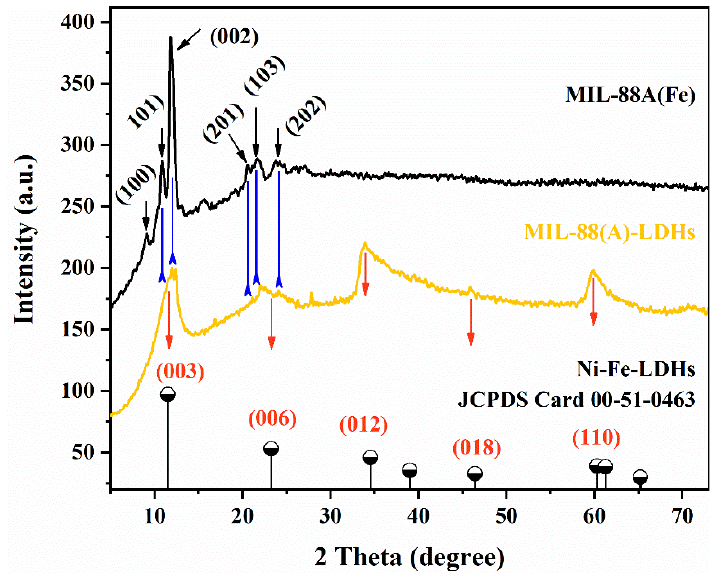
Figure 1. PXRD patterns of LDHs, MIL-88A(Fe), and MIL-88A-LDHs. The SEM images of LDHs, MIL-88A(Fe), and MIL-88(A)-LDHs, are shown in Figure